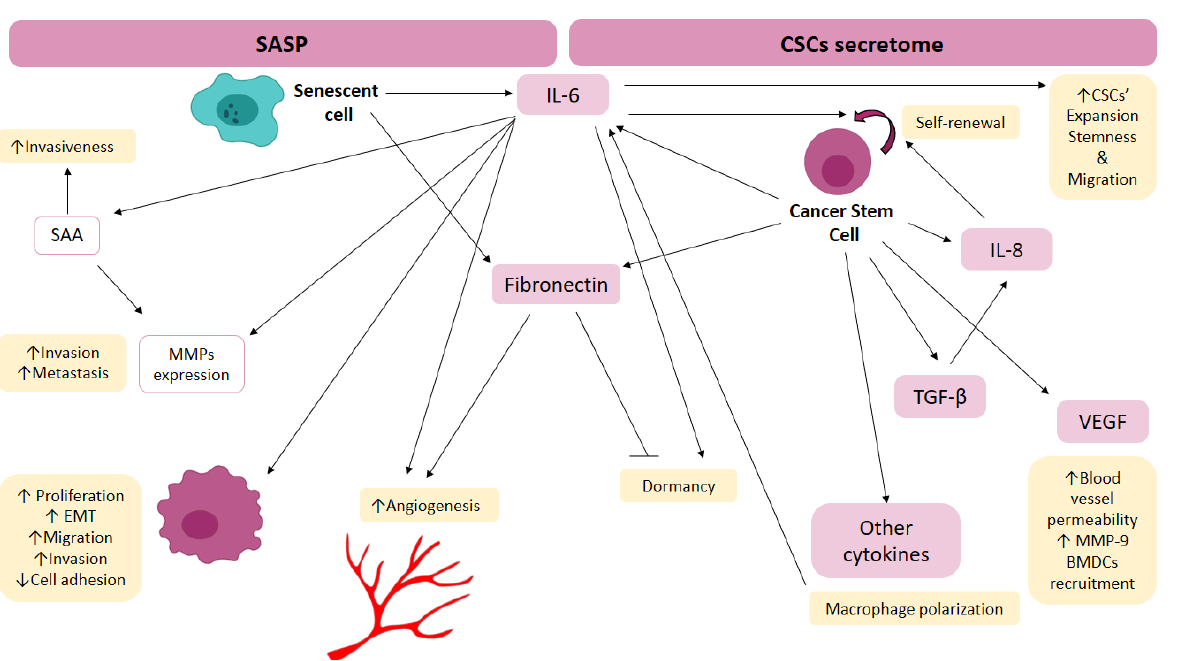
Figure 3. Effect of hypoxia on cellular components of the premetastatic niche.